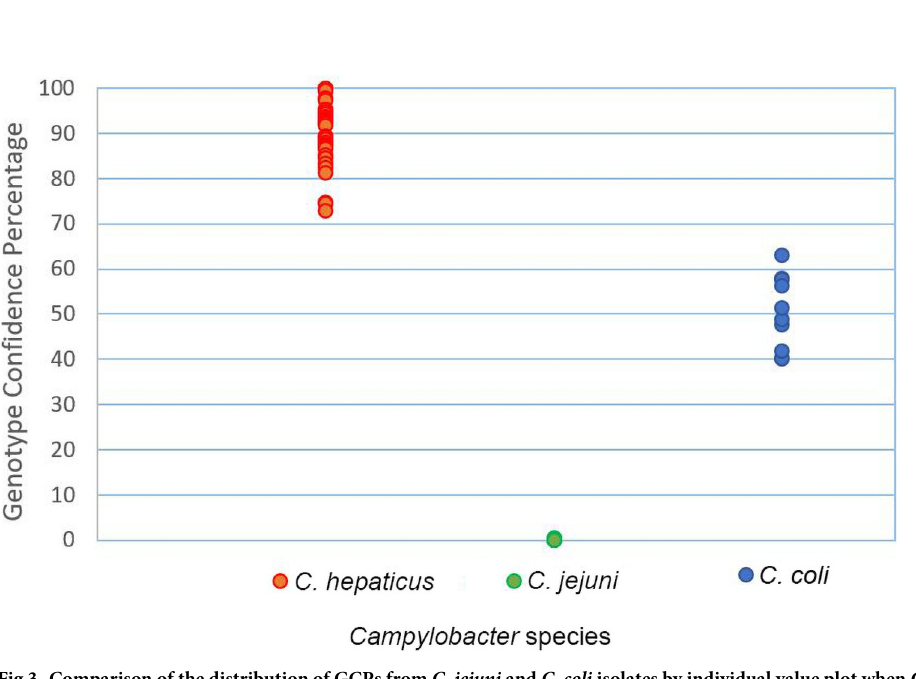
Fig 2. Conventional and normalised melt curve analysis of Campylobacter strains and isolates. a) Conventional and b) normalised melt curve analysis of PCR amplicons.